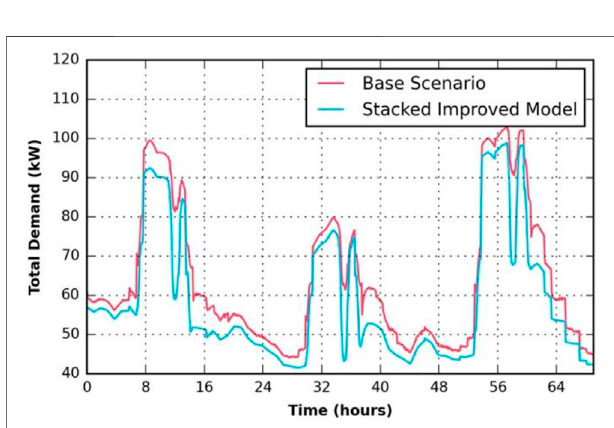
FIGURE 17 | Adjusting building consumption patterns as a result of adopting and stacking scenarios 2 through 6.